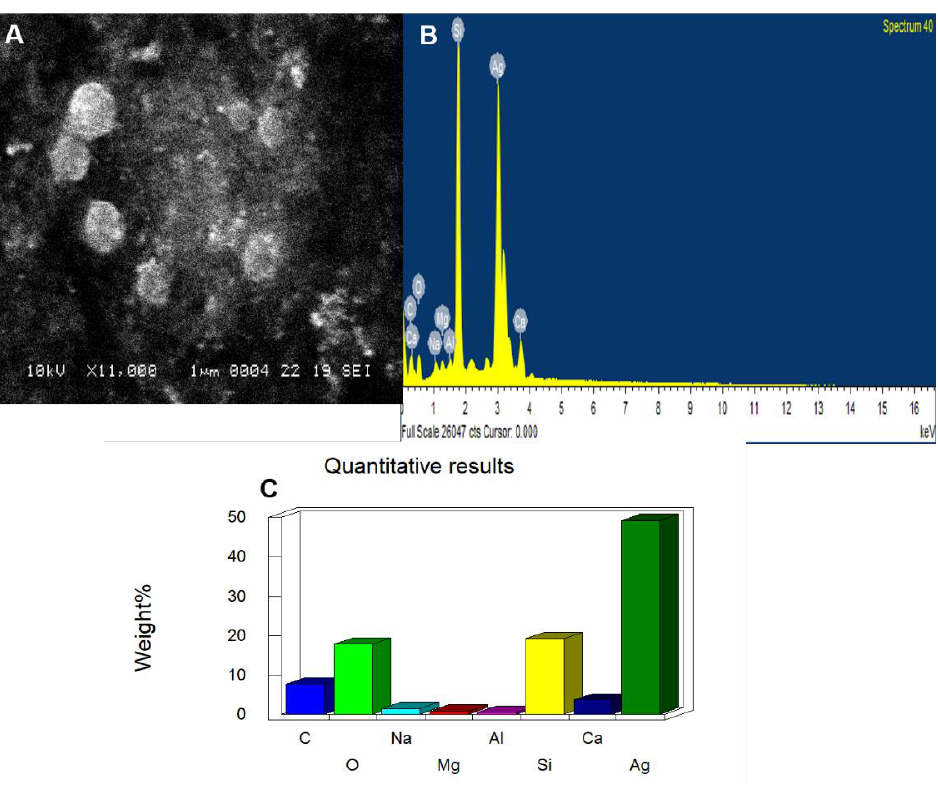
Figure 3. Characterization of AgNPs. ( A ) SEM image of AgNPs; ( B ) EDAX spectrum of AgNPs; ( C ) quantitative results obtained by EDAX from Ajwa date extract.